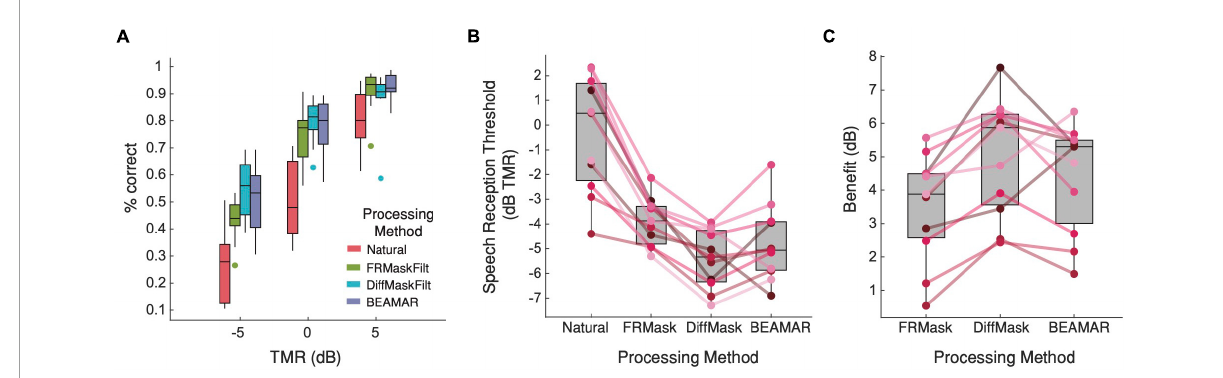
FIGURE5 Behavioral evaluation results. (A) Average percent correct for each processing condition as a function of TMR. n = 11. Higher is better. (B) Average and individual subject speech reception threshold for each processing method. Lower is better. Solid lines connect the SRTs for each participant. (C) Average and individual subject perceptual benefits relative to the natural condition. Higher is